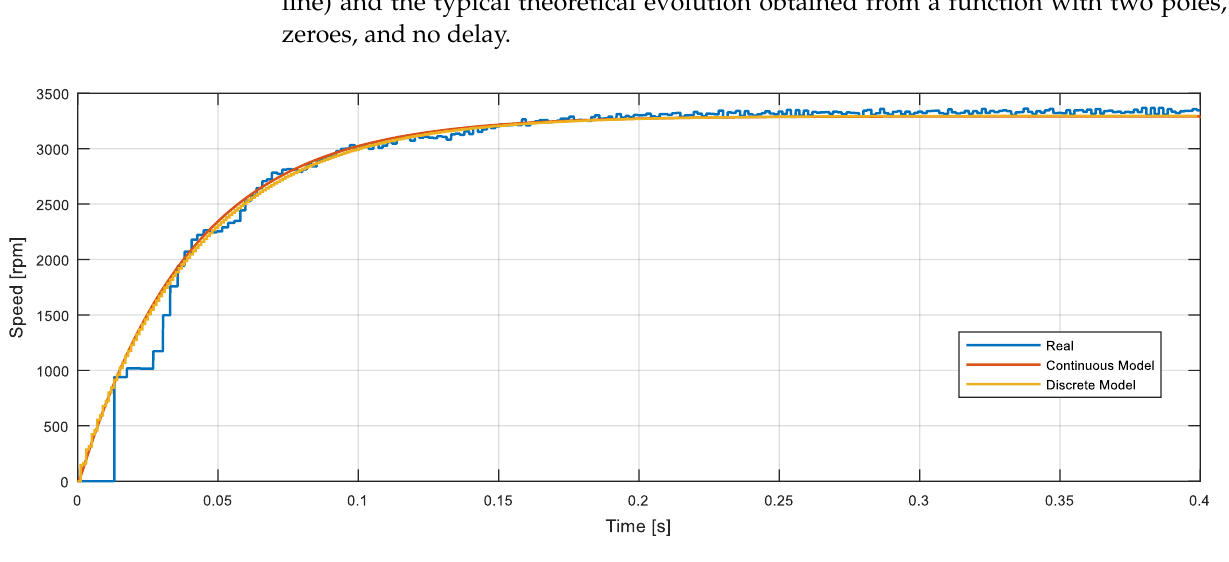
Figure 13. ( a ) Real motor setup. ( b ) Simulation of the motor model.